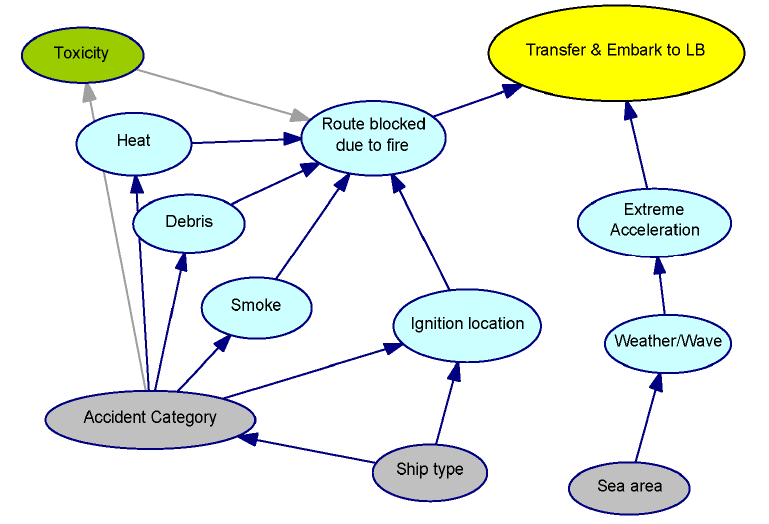
Figure A4. A Bayesian network for transfer and embarkation to lifeboats in flooding accidents (04 FL ).